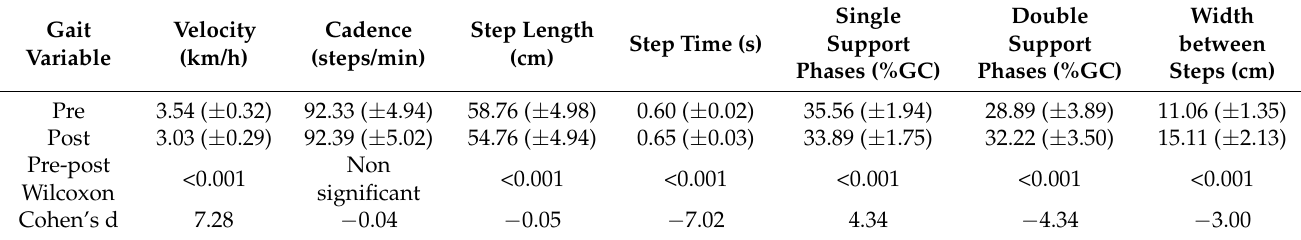
Table 2. Spatio-temporal gait parameters of study participants (mean values ± SD) before (pre) and after (post) the exhaustive exercise. Results of Wilcoxon matched-pairs signed rank test between before and after the exercise are also